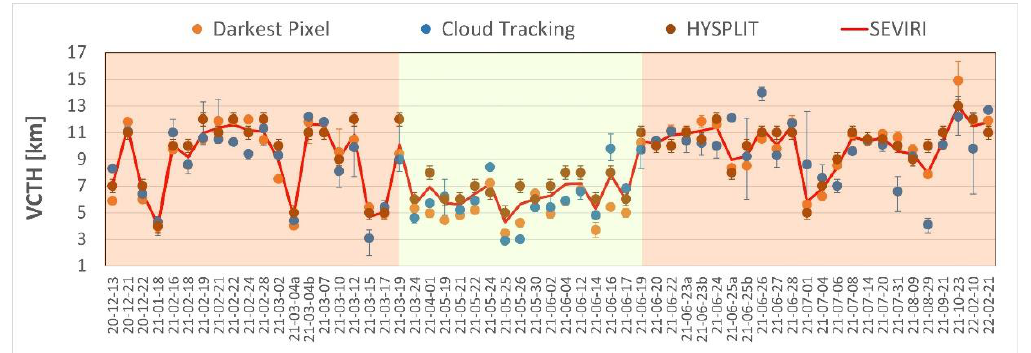
Figure 7. Time series of the VCTH obtained using the DP, CT, and HY procedures for all the 2020–2022 Etna LFs. The error bars represent the uncertainties of the three methods as described in Section 2.1. The red solid line indicates the VCTH weighted mean (Equations (1)–(3)) used as input in the VPR procedure. The “Date” labels ( x -axis) are in the format year-month-day, with letters a and b to distinguish the LFs that occurred on the same day.